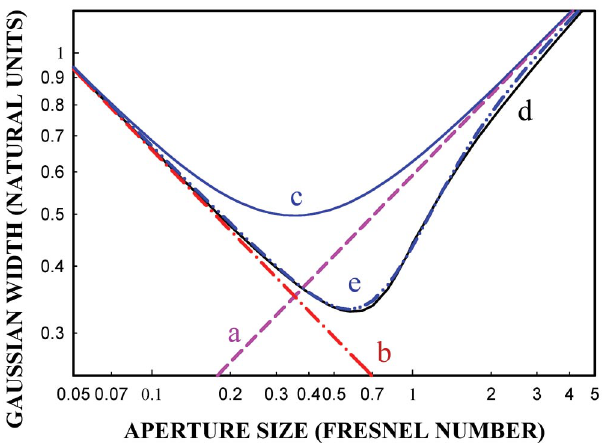
FIG. 3. (Color) Calculated Gaussian width of PSF profiles of a pinhole camera with different models: (a) geometric projection, (b) Fraunhofer diffraction, (c) hybrid model (quadrature sum of the previous two) [18,19], (d) Fresnel diffraction, and (e) fit to (d), as shown in Eq. (4).